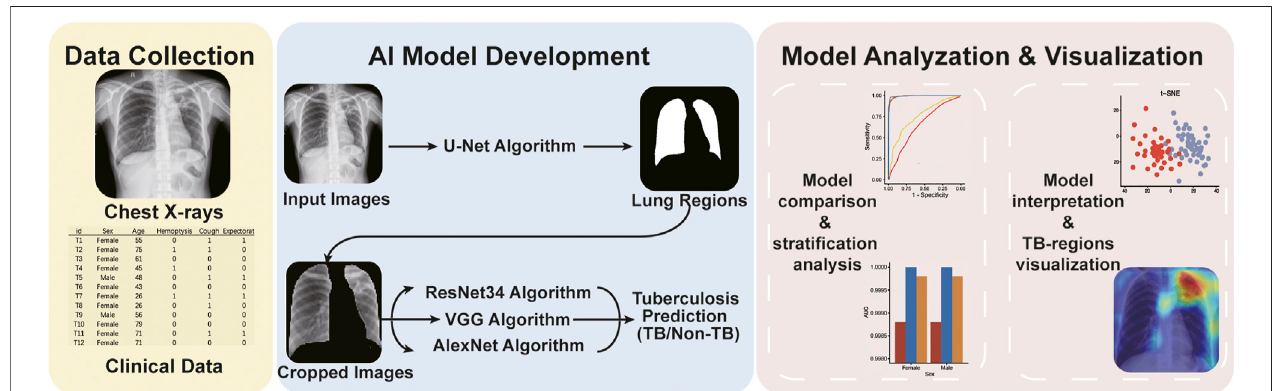
FIGURE 1 | The work fl ow of the